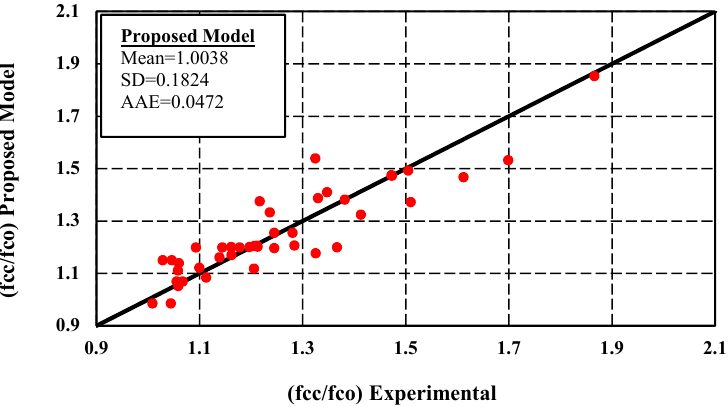
f cc 𝒇 𝒄𝒄 values obtained from the proposed model and experimental values obtained from the proposed model and experimental data. Figure 6. Comparison of f co 𝒇 𝒄𝒐